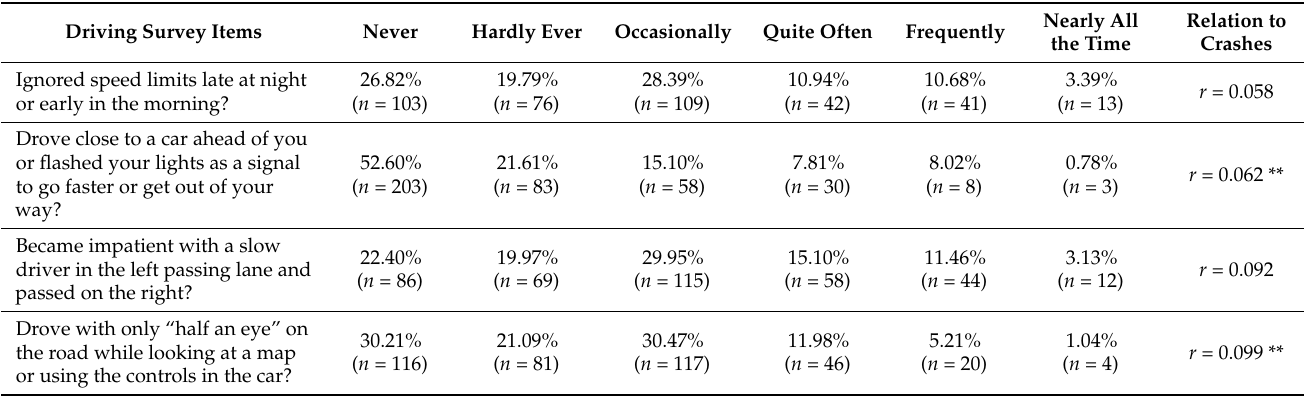
Table 2. Risky driving behavior frequencies and correlations with crashes. Note: ** = statistically significant correlation with crashes where p <